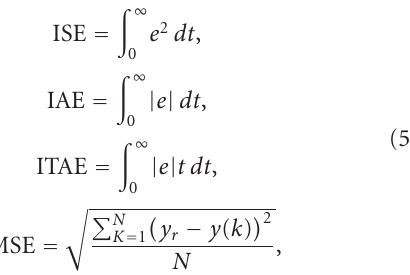
Figure 11: Experimental results of fuzzy-coordinated PI controller, control input, and PI gains tuning for the set pressure level of 4bar.